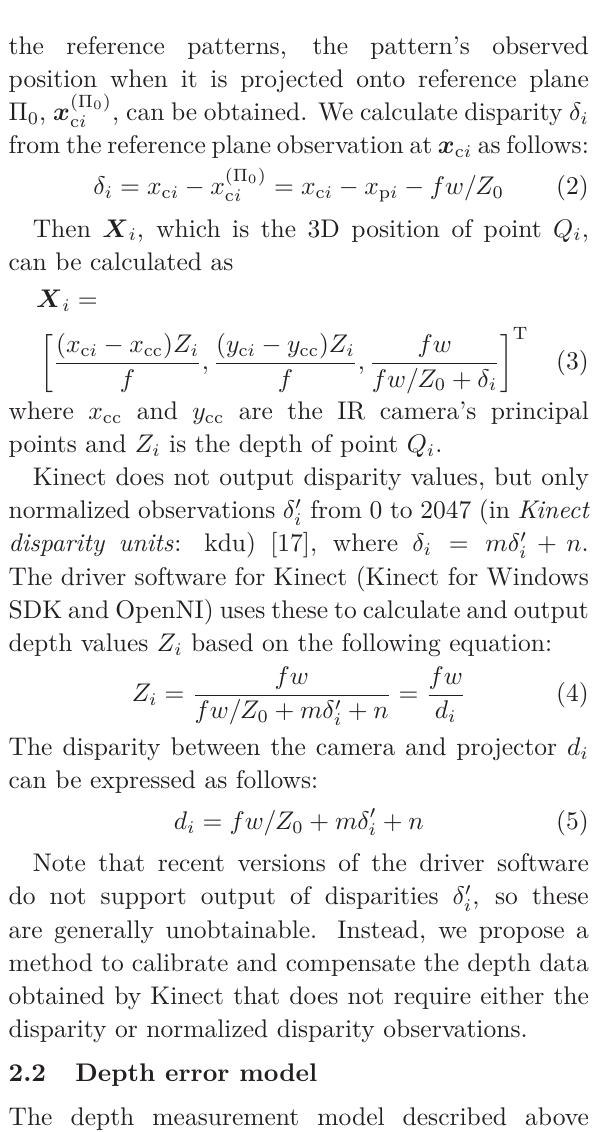
Fig. 2 Depth measurement by